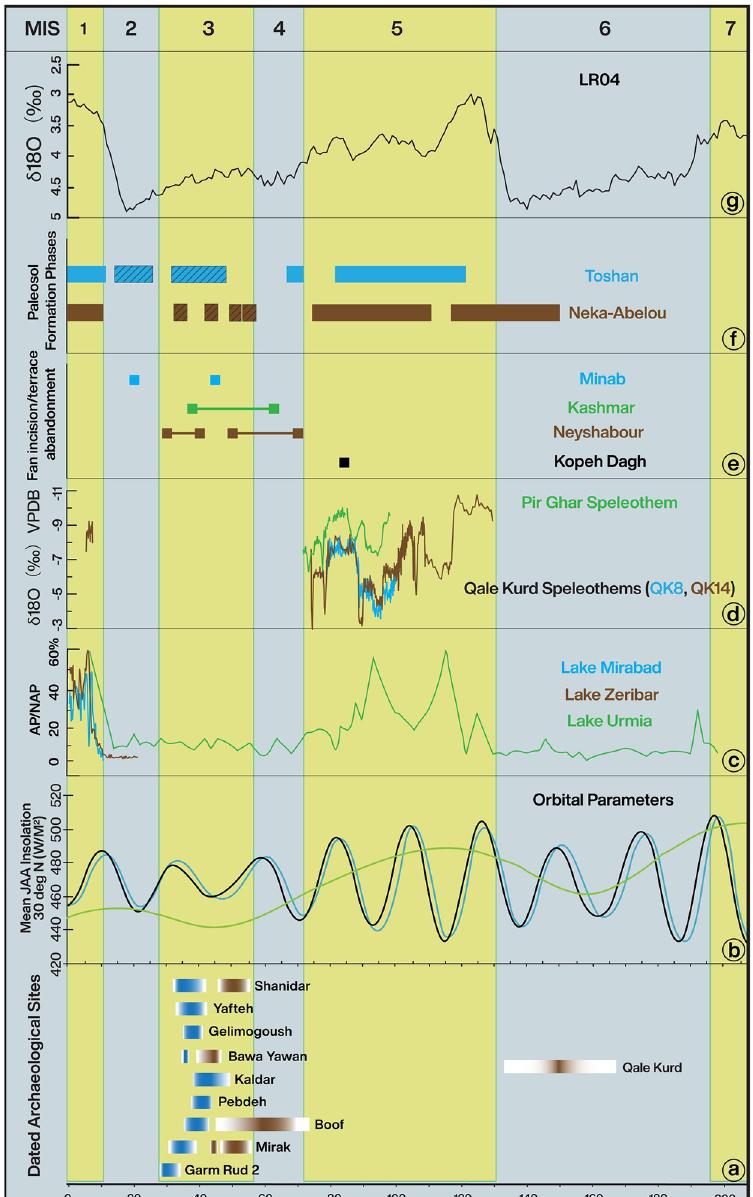
Fig 5. The relationship between dated archaeological sites in Iran and diverse regional environmental proxies. A) Dated archaeological sites with Middle (brown) and Upper (blue) Paleolithic affinities. B) Orbital parameters (eccentricity, green; and precession, blue) which influence local insolation receipt (black). C) Pollen record from Lake Urmia, Zeribar and Mirabad lakes from along the northern to central Zagros, showing arboreal to non-arboreal pollen ratio, suggestive of forest/shrubs vegetation during MIS 5 and 1 [63, 67, 93]. D) Speleothem studies from Qaleh Kurd in western and Pir Ghar in the eastern Iranian Plateau, showing wetter conditions during phases of MIS 5 and also the Holocene [44, 78]. E) Alluvial fan and river terrace abandonment [80, 81]. F) Paleosol formation phases, weakly developed loess soils are shown by black diagonal lines [72, 73]. G) Oxygen isotope values from the LR04 global benthic stack